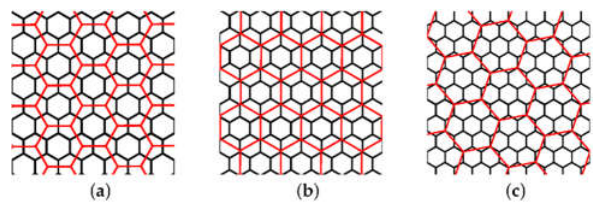
Figure 5 . Multi-resolution hexagonal grids: (a) aperture 3, (b) aperture 4, (c) aperture 7 (Uher et al.,